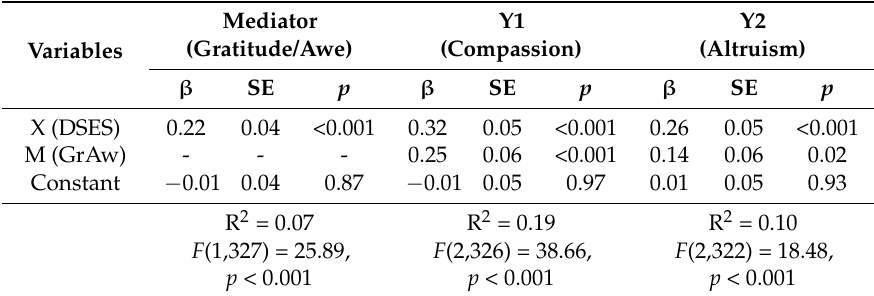
Table 6. Model coefficients for Compassion and Altruism mediated by Gratitude/Awe.